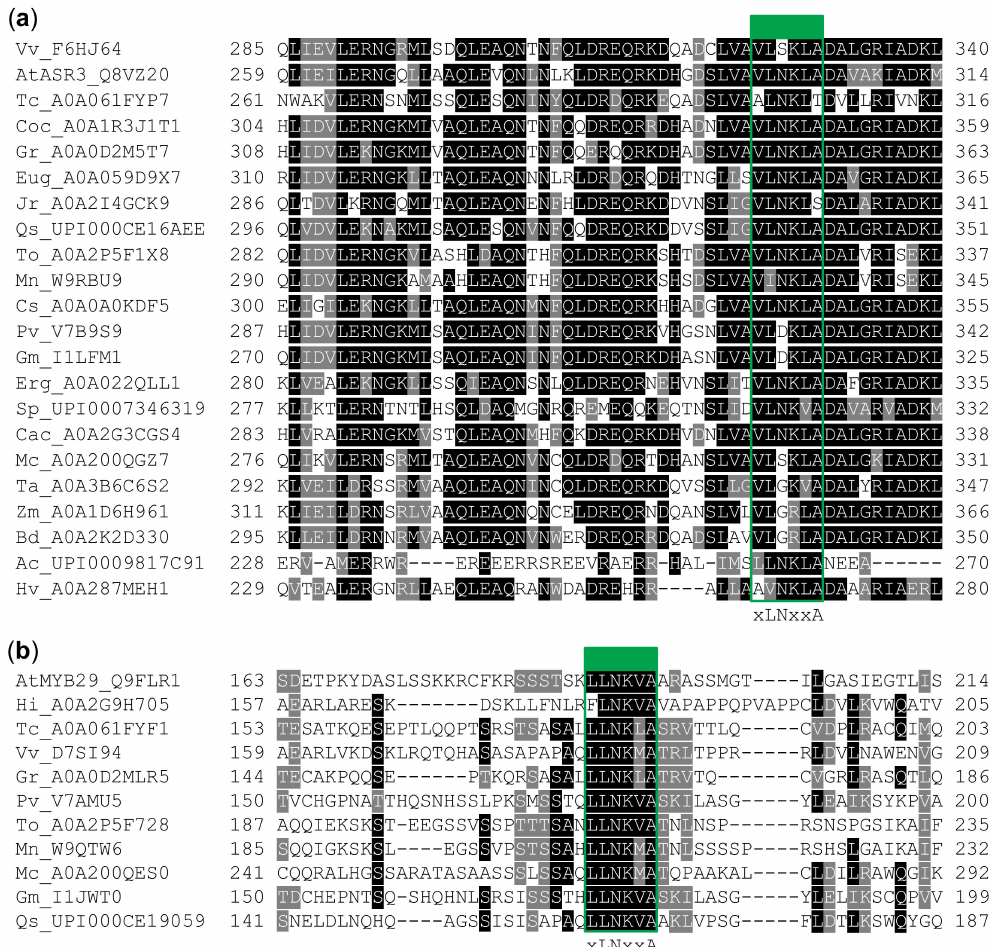
Figure 5. Alignments of ( a ) trihelix TFs and ( b ) R2R3 MYB TFs colored according to conservation, performed using BoxShade (https://embnet.vital-it.ch/software/BOX_form.html). For each position where a consensus (>50%) could be defined, residues identical to this consensus were colored black, while those similar were colored gray. A green border and box highlight the putative motifs. Vv: Vitis vinifera , At: A. thaliana , Tc: Theobroma cacao , Coc: Corchorus capsularis , Gr: Gossypium raimondii , Eug: Eucalyptus grandis , Jr: Juglans regia , Qs: Quercus suber , To: Trema orientale , Mn: Morus notabilis , Cs: Cucumis sativus , Pv: Phaseolus vulgaris , Gm: Glycine max , Erg: Erythranthe guttata , Sp: Solanum pennellii , Cac: Capsicum chinense , Mc: Macleaya cordata , Ta: Triticum aestivum , Zm: Zea mays , Bd: Brachypodium distachyon , Ac: Ananas comosus , Hv: Hordeum vulgare , Hi: Handroanthus impetiginosus